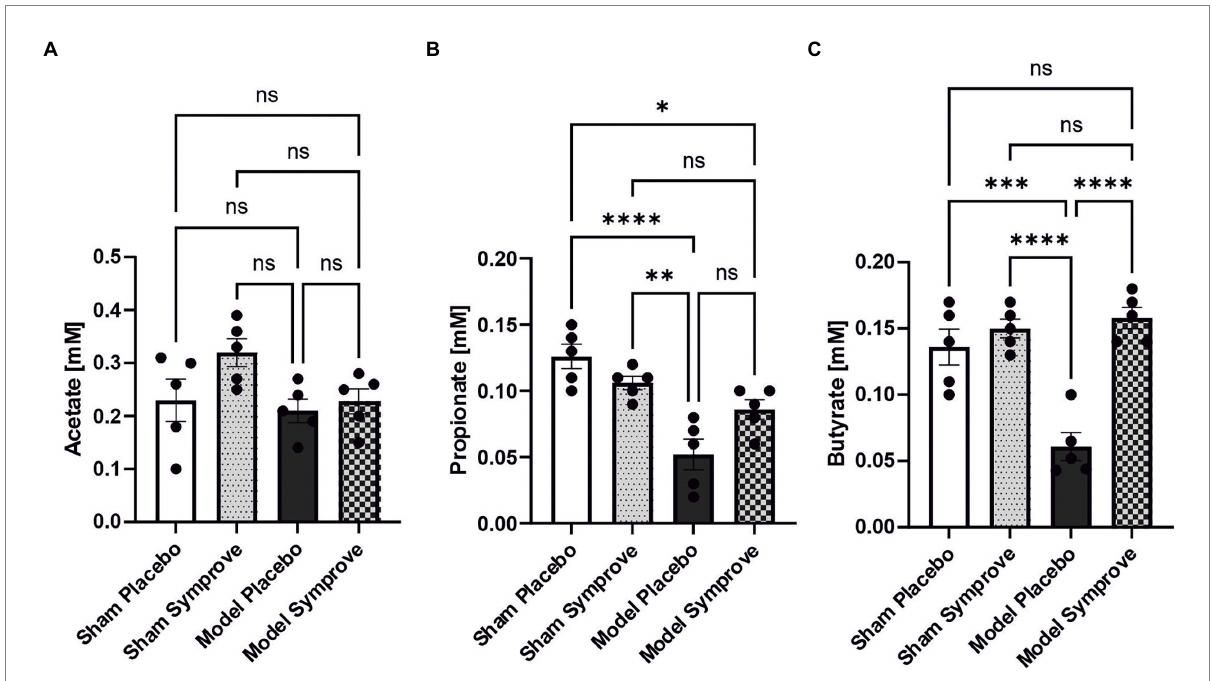
FIGURE 9 Effect of Symprove ™ on short chain fatty acid levels in stool samples collected from all experimental groups: Sham + placebo, Sham + Symprove ™ , model + placebo and model + symprove ™ . (A) Effect of Symprove ™ effects on acetic acid (A) , propionic acid (B) and butyric acid (C) levels in stools. Acetate levels were not significantly modified, while propionate and butyrate levels were reduced in the model and Symprove ™ treatment significantly prevented butyrate loss but not completely, the propionate decrease. All data are shown as means ± S.E.M. * p < 0.05, ** p < 0.01, *** p < 0.001, and **** p <